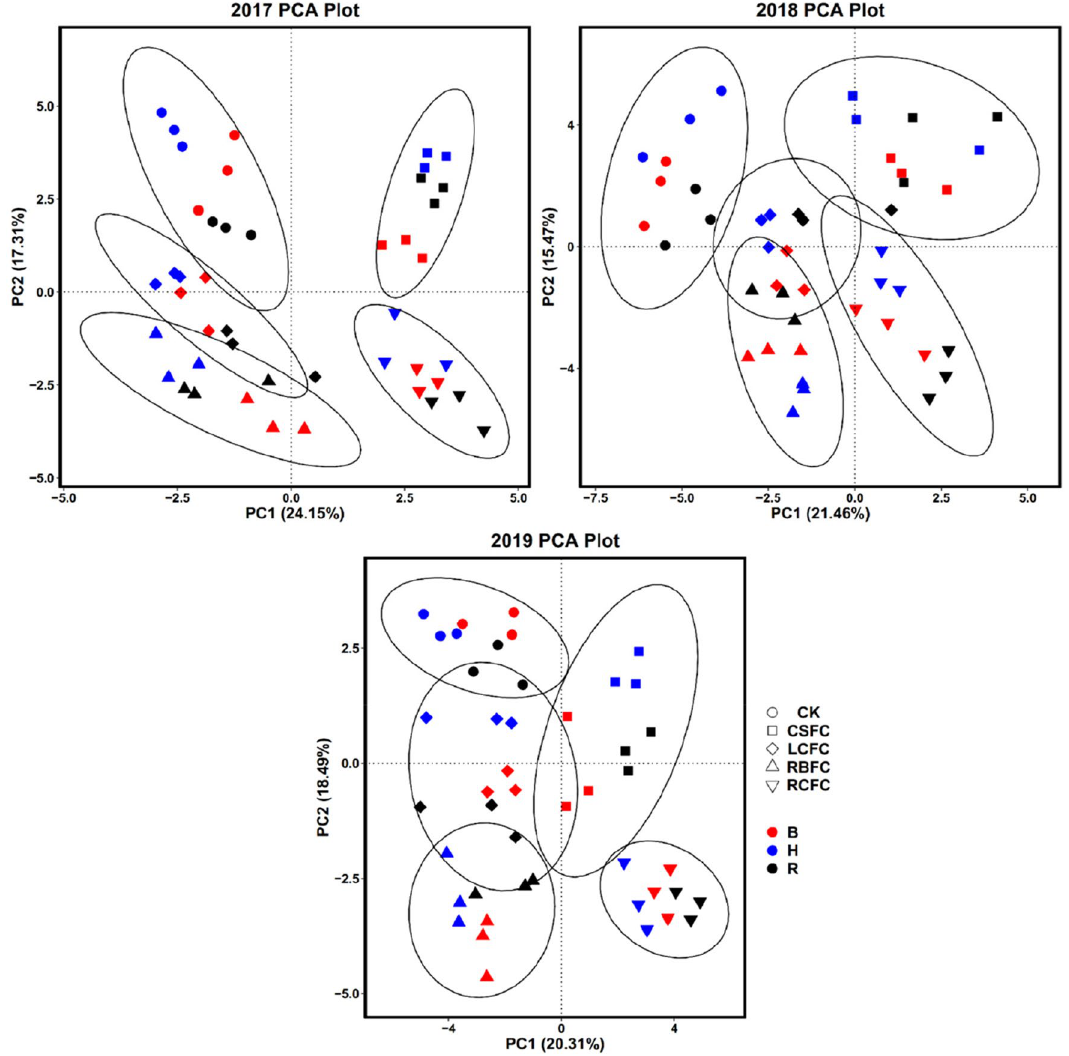
Figure 3. Two-dimensional plot of the principal components analysis (PCA) for the top ten abundant bacterial phyla in the different treatments at rosette (R), budding (B) and harvesting (H) stage in 2017, 2018 and 2019.